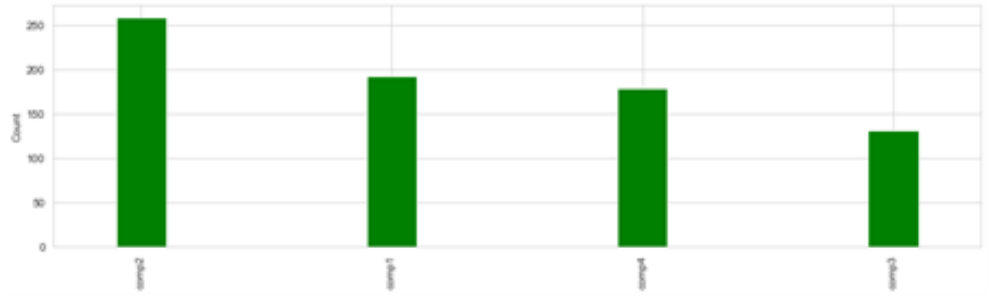
Figure 6. Records of component replacements that have occurred as a result of failures. A date and time stamp, machineID, and failed component type are all included in each entry.